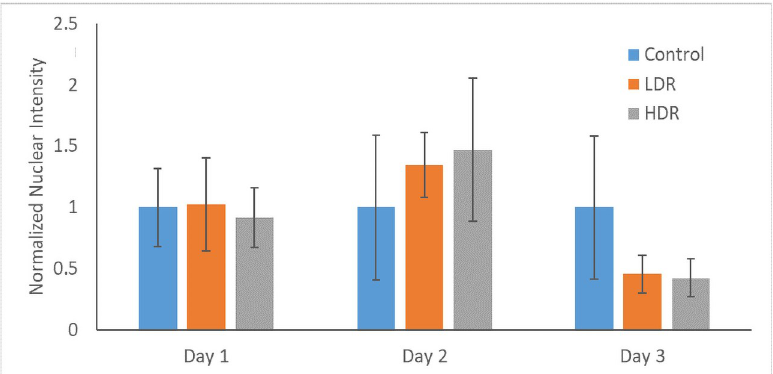
Fig 8. Normalized nuclear intensity of p21 expression. Data is normalized to control of each time point.